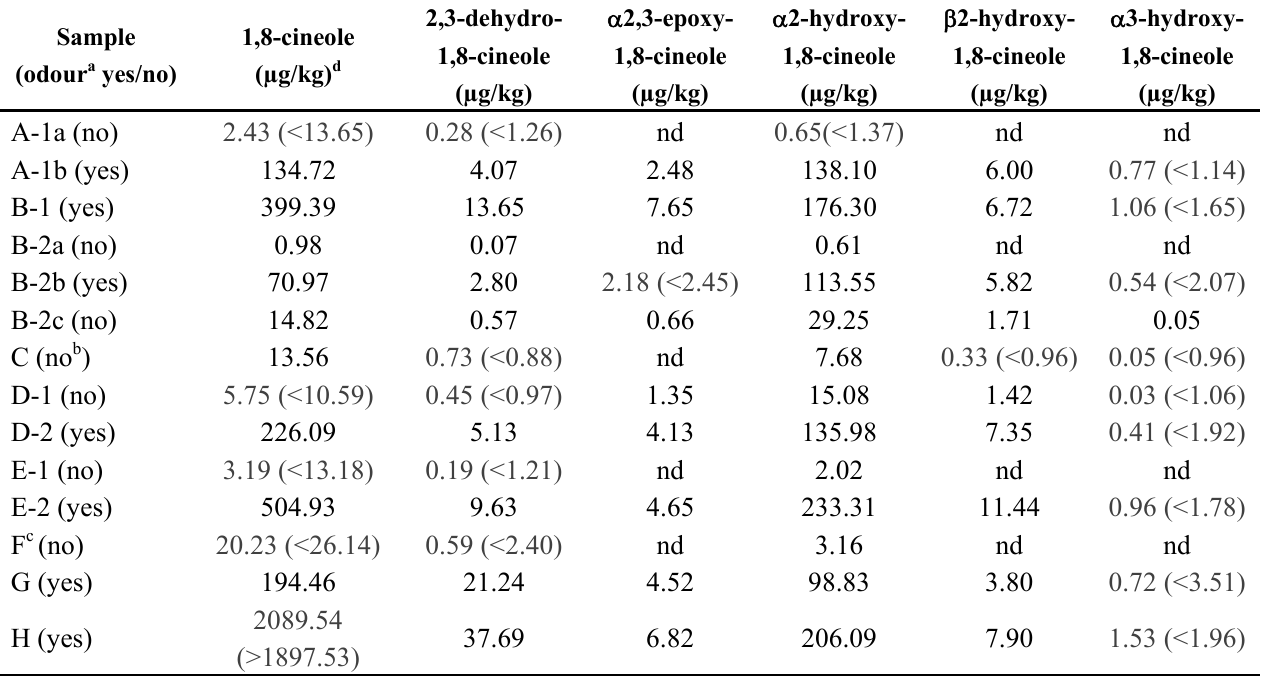
Table 1. Absolute concentrations of metabolites of 1,8-cineole in human milk samples (single determinations).